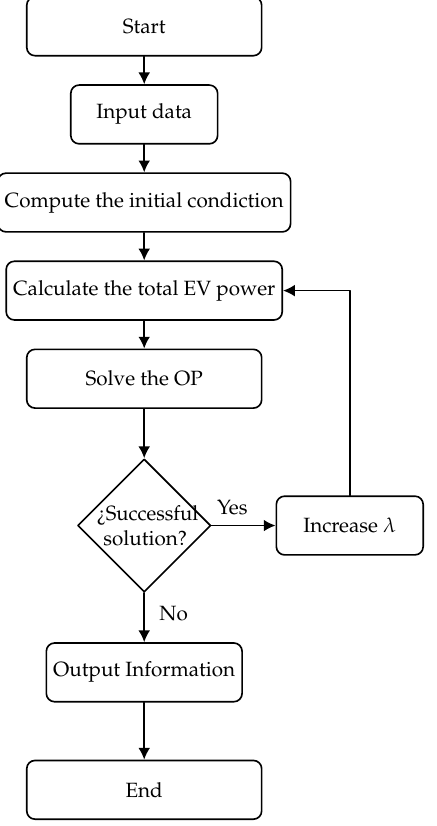
Figure 3. Flowchart for the DG and EV hosting capacity evaluation. OP represents the optimization problem shown in Equation